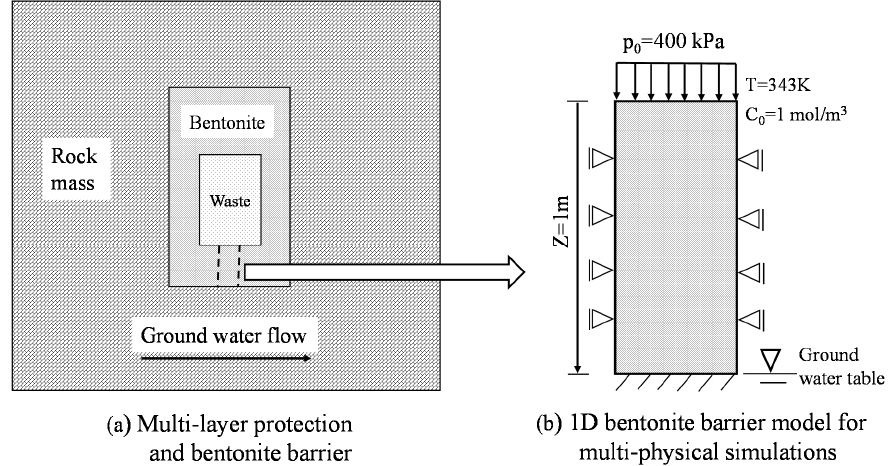
Figure 5. Diagram of the nuclear waste repository cavern and computational model. (( a ) Schematic of multiple safeguards for nuclear waste storage. ( b ) Schematic diagram of multi-physical field coupling simulation of bentonite).